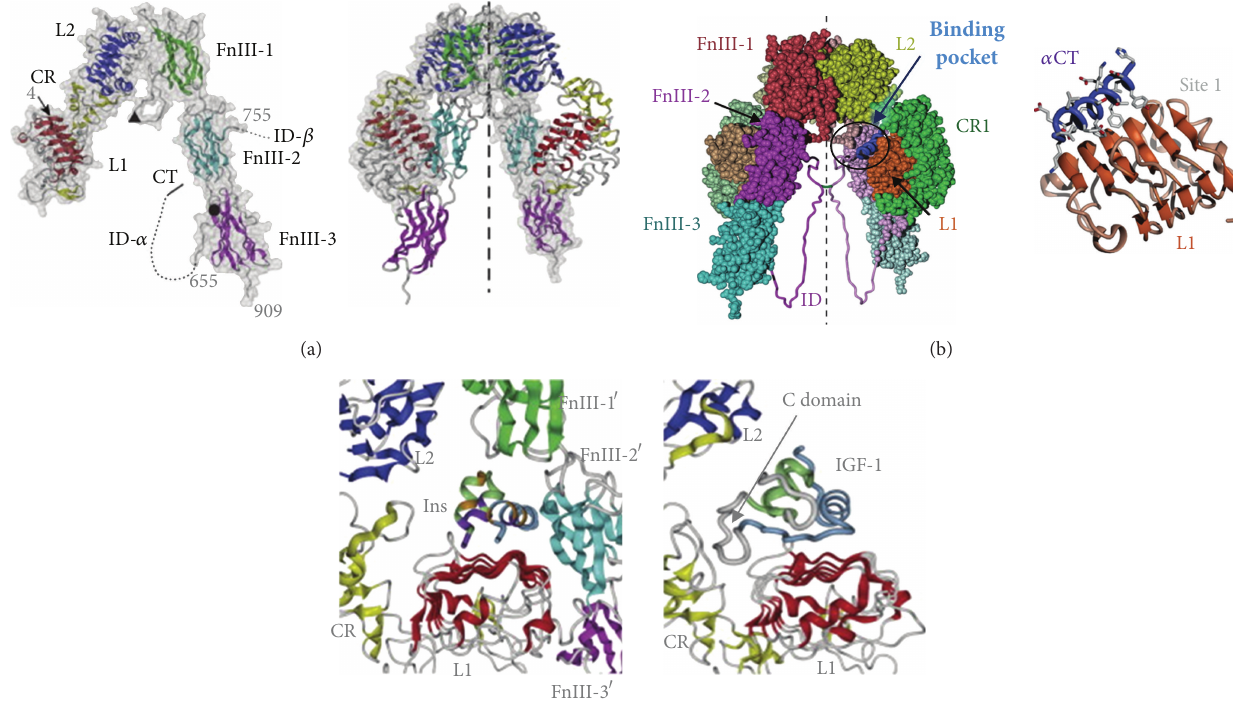
Figure 7: Representation of the crystal structure of the ectodomain of the insulin receptor and model for the interaction of insulin and IGF-1 with their cognate receptors. The three-dimensional structures of a monomer (LHS) and homodimer (RHS) of the insulin receptor isoform B ectodomain are shown (a). Domains are coloured: L1, red; CR, yellow; L2, blue; FnIII-1, green; FnIII-2, cyan; and FnIII-3, magenta. The observed location of the inter- 𝛼 -chain disulphide at Cys524 is indicated by a ( 󳵳 ) symbol, the 𝛼 - 𝛽 chain disulphide at Cys647–Cys860 by a ( ∙ ) symbol. Images are taken with permission from [312]. The structures of 𝛼 -chain residues 1–3 ( 𝛼 -chain N-terminus) and 656–719 (ID- 𝛼 /CT) and of 𝛽 -chain residues 724–754 (ID- 𝛽 ) and 910–917 (C-terminus of ectodomain) were not solved. The observed termini of the regions of resolved structure within the insert domain of the 𝛼 -chain and 𝛽 -chain of the ectodomain monomer are numbered. The insulin receptor ectodomain homodimer is illustrated in its apoconformation, with the twofold symmetry axis indicated by a dashed vertical line ((b), LHS) [85]. The first monomer at the front of the depiction is shown in saturated colour and the second monomer in less intense colour. The thin tubes of the insert domains (ID) indicate their speculative paths. The circled region identified by a blue arrow represents one binding pocket. The region contains the juxtaposition of the residues, derived from L1 of the first monomer and the 𝛼 CT helix of the second monomer that contribute to binding Site 1 with the residues, derived from the FnIII-1 and FnIII-2 junction of the second monomer that contribute to Site 2. The Site 1 tandem element, formed by the surface of the central 𝛽 -sheet of L1 of the first insulin receptor monomer and the 𝛼 CT helix of the second insulin receptor monomer, is shown (RHS). Images are taken with permission from [86]. The proposed location of insulin bound in an insulin receptor binding pocket formed between two insulin receptor monomers with Site 1 from mainly one monomer and Site 2 󸀠 from the second monomer of the insulin receptor ectodomain [85, 107, 312] is shown in (c) (LHS). Domains of the receptor are coloured as in (a). Colouring of individual C 𝛼 positions within insulin is as follows: residues forming binding Surface 1 of insulin, A1–3, A5, A19, A21, B12, and B16, are shown in purple; residues forming binding Surface 2, A12-13, A17, B13, B17, and B19, are shown in orange; the remaining A-chain residues are in light green and remaining B-chain residues in light blue. Insulin residues B22–B30 are omitted from the model [107]. The proposed location of IGF-1 bound at Site 1 of type I IGF receptor binding pocket is shown (RHS) [313]. The colouring of domains of the type I IGF receptor follows that of the insulin receptor in (a). The backbone of IGF-1 is coloured according to the corresponding colours of the A and B chains of insulin outlined above. The images are taken with permission from